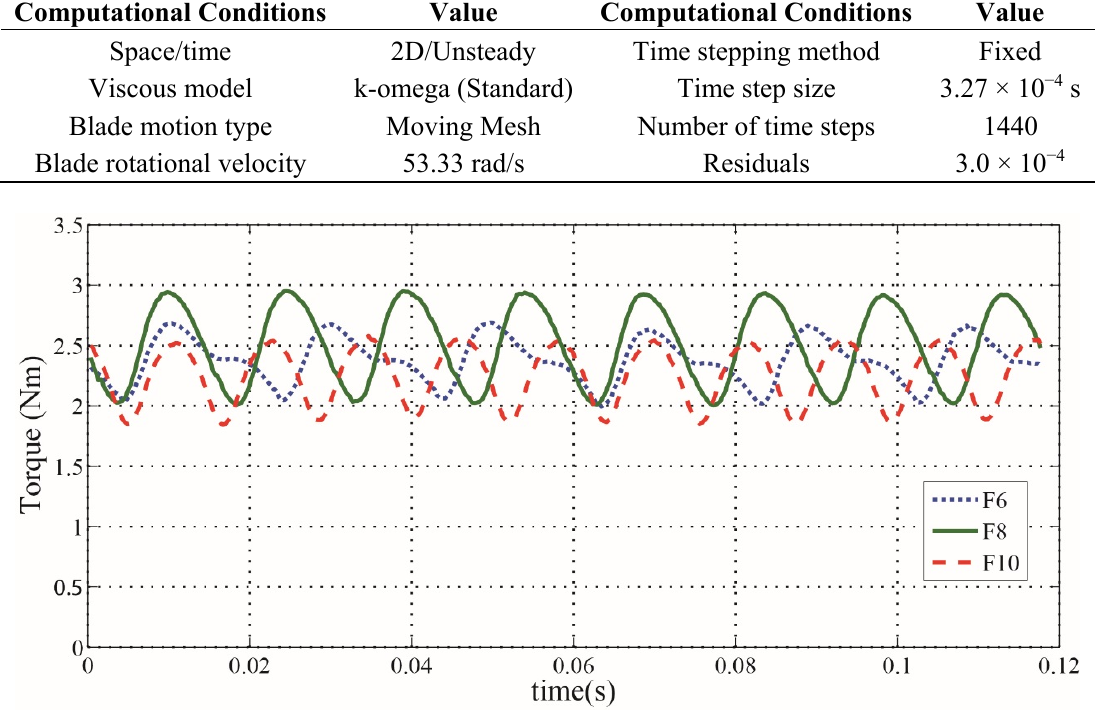
Figure 11. Torque generated on the center of rotor F for one